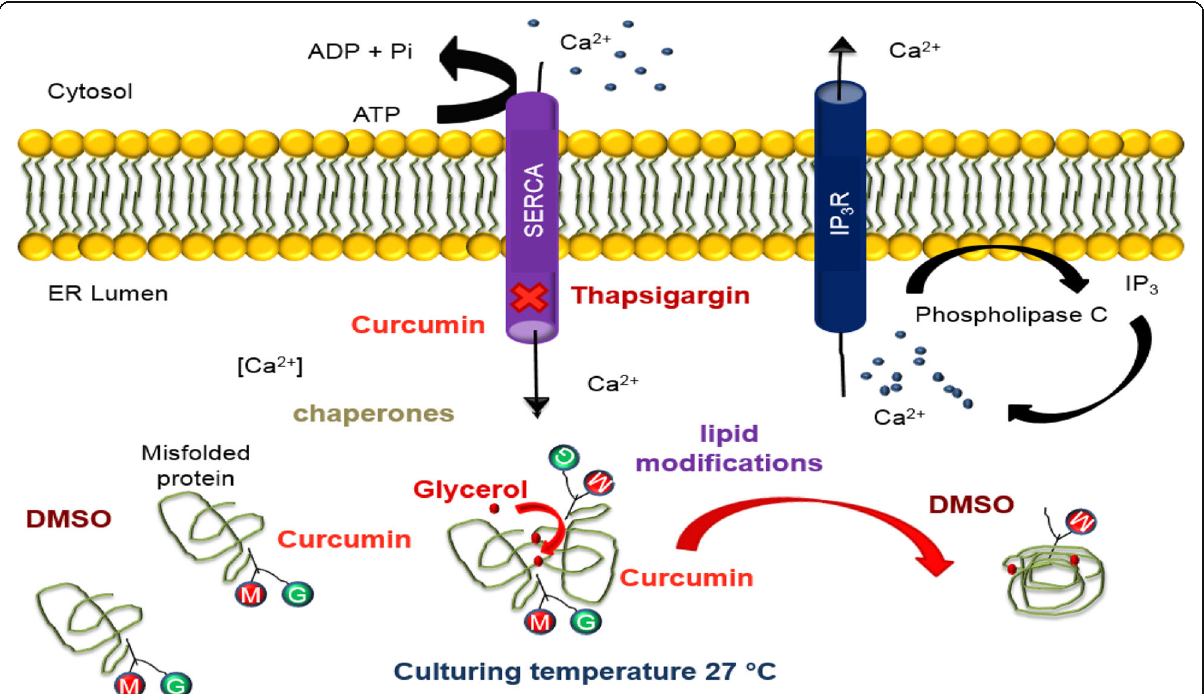
Fig. 5 The effects of targeting the intracellular environment of proteostasis. Glycerol has the ability to increase the hydration layer of the protein and the intramolecular hydrophobic bonding strength. This in turn allows the free movement of proteins in the crowded environment of the ER thereby preventing aggregation of proteins. Differing concentrations (0.1 – 1%) of DMSO in a cell may increase protein synthesis of the misfolded proteins or by possibly overwhelming the quality control system. Thapsigargin acts as an inhibitor of the Ca 2+ ATP2A pump pump and increases cytosolic calcium, and in doing so results in an enhanced rescue of mutant proteins (Robben et al. 2006). Curcumin is a nontoxic natural constituent of turmeric spice and affects the Ca 2+ ATP2A pump found on the ER plasma membrane. Curcumin inhibits the pumps ability to maintain a high ER Ca 2+ level which disturbs the ability of ER molecular chaperones to target the misfolded protein for ERAD, hence, allows the mutant protein to exit the ER. Post- translational modifications of lipid modifications and glycosylation can be therapeutically targeted to support disulfide bond and